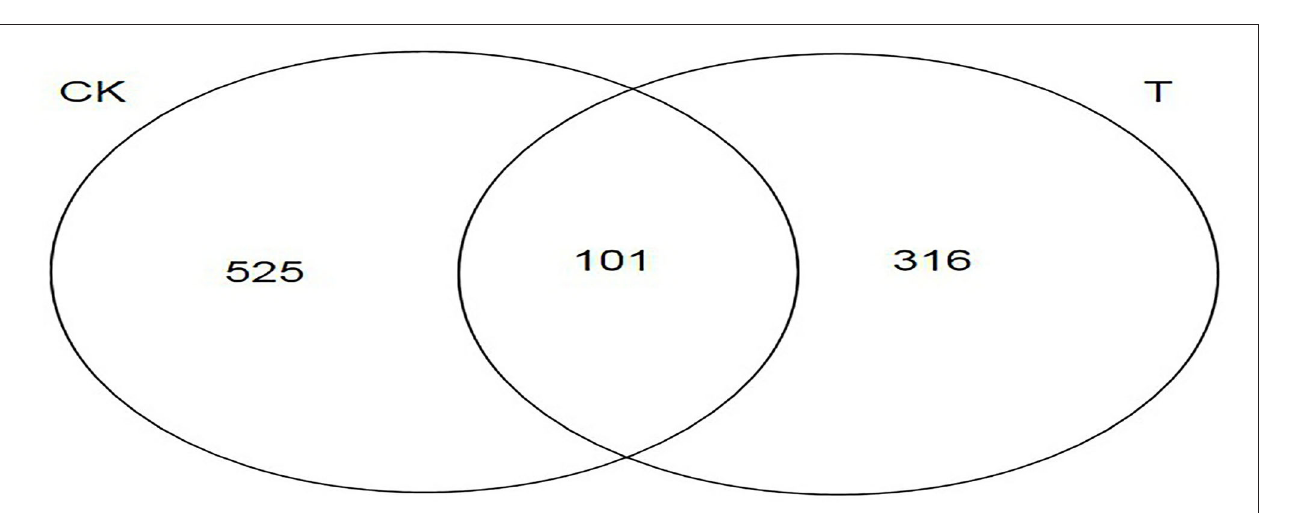
FIGURE 5 | Venn diagram analysis based on operational taxonomic units (OTUs) for different groups. The number of overlapping parts is the number of OTUs shared between the two samples (CK, SBM; T,